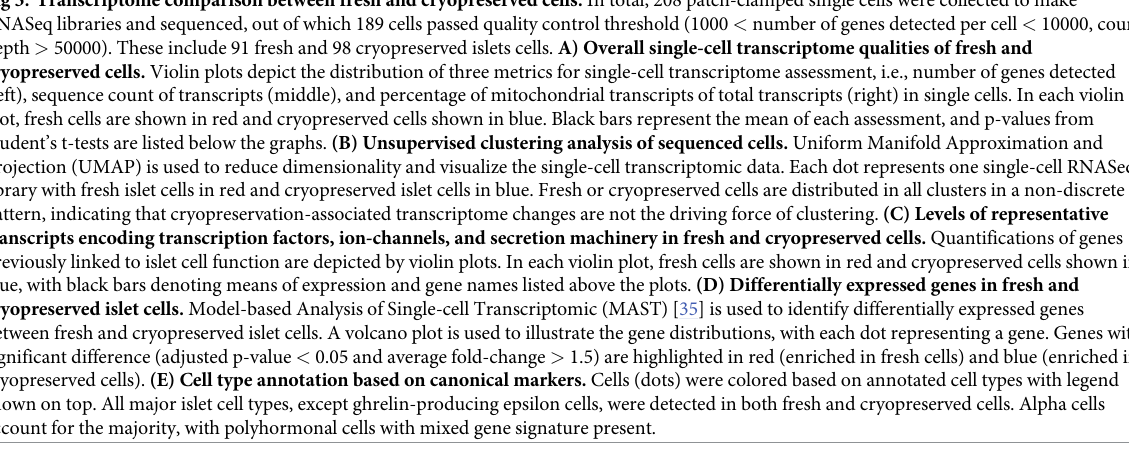
Fig 5. Transcriptome comparison between fresh and cryopreserved cells. In total, 208 patch-clamped single cells were collected to make RNASeq libraries and sequenced, out of which 189 cells passed quality control threshold (1000 < number of genes detected per cell < 10000, count depth > 50000). These include 91 fresh and 98 cryopreserved islets cells. A) Overall single-cell transcriptome qualities of fresh and cryopreserved cells. Violin plots depict the distribution of three metrics for single-cell transcriptome assessment, i.e., number of genes detected (left), sequence count of transcripts (middle), and percentage of mitochondrial transcripts of total transcripts (right) in single cells. In each violin plot, fresh cells are shown in red and cryopreserved cells shown in blue. Black bars represent the mean of each assessment, and p-values from Student’s t-tests are listed below the graphs. (B) Unsupervised clustering analysis of sequenced cells. Uniform Manifold Approximation and Projection (UMAP) is used to reduce dimensionality and visualize the single-cell transcriptomic data. Each dot represents one single-cell RNASeq library with fresh islet cells in red and cryopreserved islet cells in blue. Fresh or cryopreserved cells are distributed in all clusters in a non-discrete pattern, indicating that cryopreservation-associated transcriptome changes are not the driving force of clustering. (C) Levels of representative transcripts encoding transcription factors, ion-channels, and secretion machinery in fresh and cryopreserved cells. Quantifications of genes previously linked to islet cell function are depicted by violin plots. In each violin plot, fresh cells are shown in red and cryopreserved cells shown in blue, with black bars denoting means of expression and gene names listed above the plots. (D) Differentially expressed genes in fresh and cryopreserved islet cells. Model-based Analysis of Single-cell Transcriptomic (MAST) [35] is used to identify differentially expressed genes between fresh and cryopreserved islet cells. A volcano plot is used to illustrate the gene distributions, with each dot representing a gene. Genes with significant difference (adjusted p-value < 0.05 and average fold-change > 1.5) are highlighted in red (enriched in fresh cells) and blue (enriched in cryopreserved cells). (E) Cell type annotation based on canonical markers. Cells (dots) were colored based on annotated cell types with legend shown on top. All major islet cell types, except ghrelin-producing epsilon cells, were detected in both fresh and cryopreserved cells. Alpha cells account for the majority, with polyhormonal cells with mixed gene signature present.